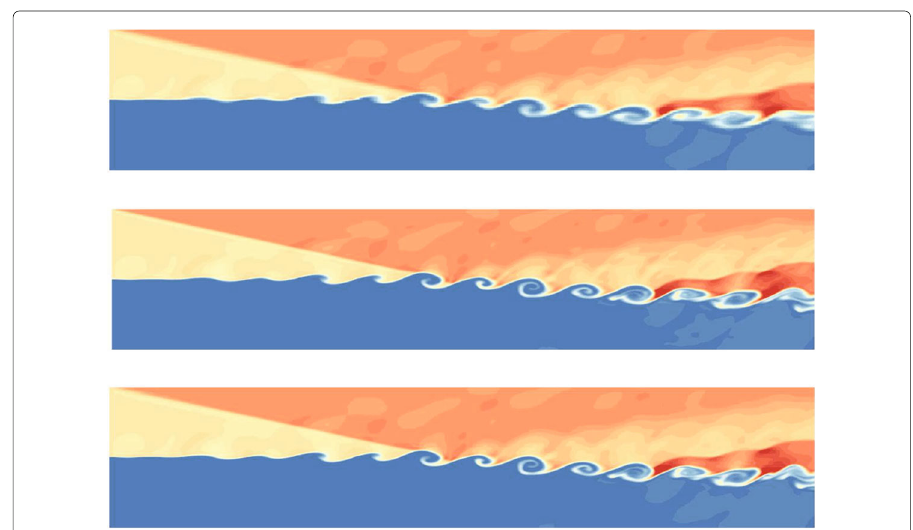
Fig. 11 Density contours on three kinds of grid at z = 20 plane. T = 120. Top: uniform coarse grids (400 × 80 × 80). Middle: uniform fine grids (800 × 160 × 160). Bottom: AMR with one refinement level based on the coarse